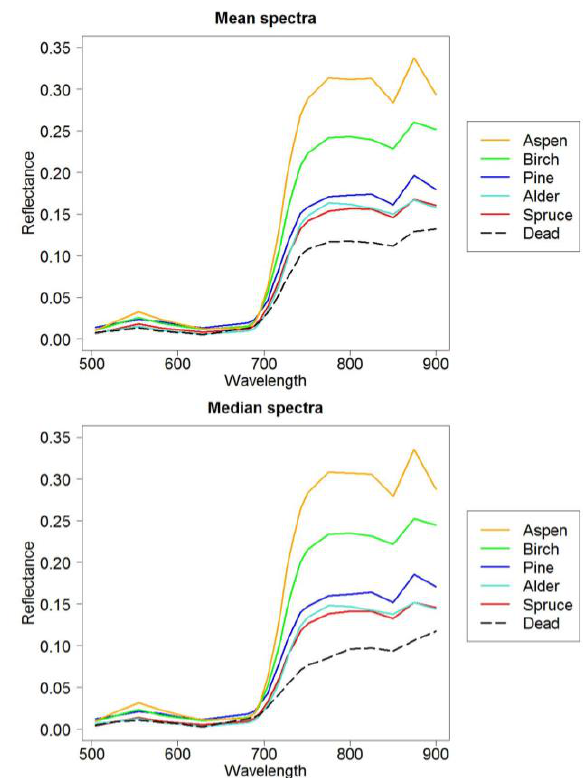
Figure 2. Mean and median spectra of various tree species (only live trees included) and dead trees